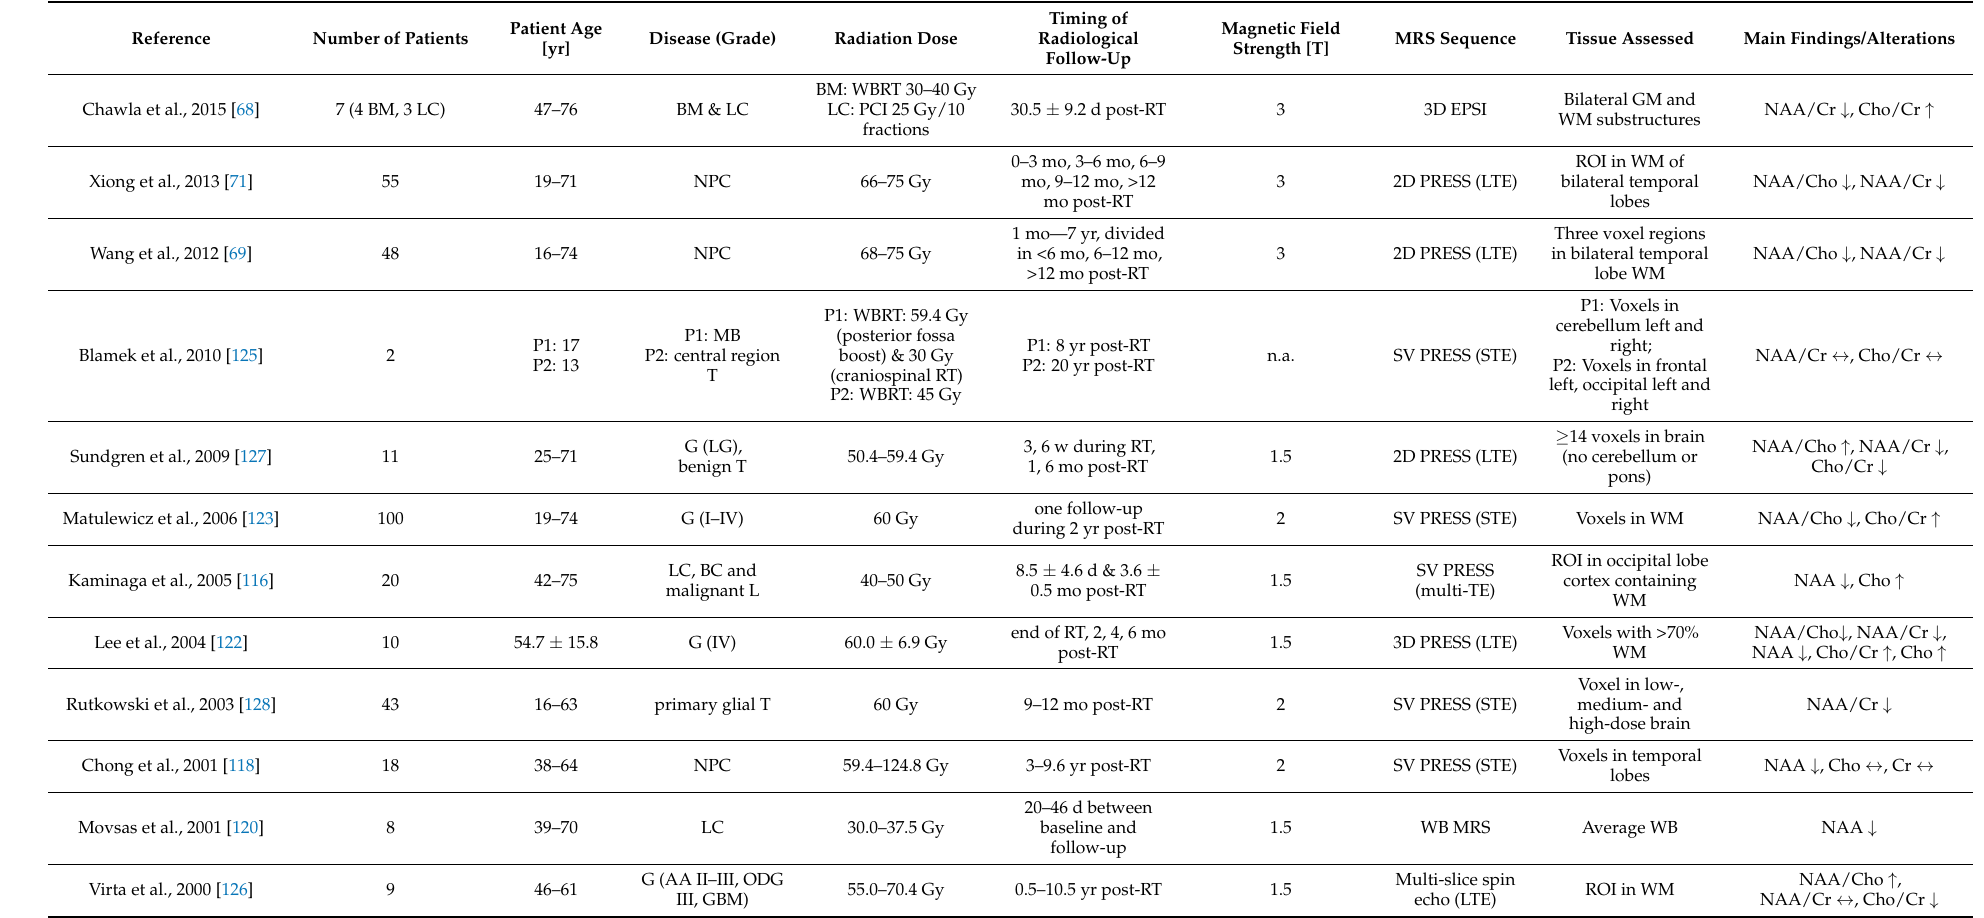
Table 4. Publications on metabolic changes in normal-appearing tissue after